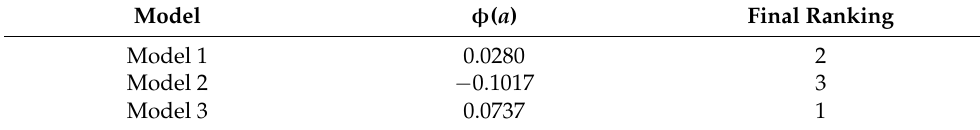
Table 11. Net outranking flow ϕ (a) and the final ranking of alternative solutions.